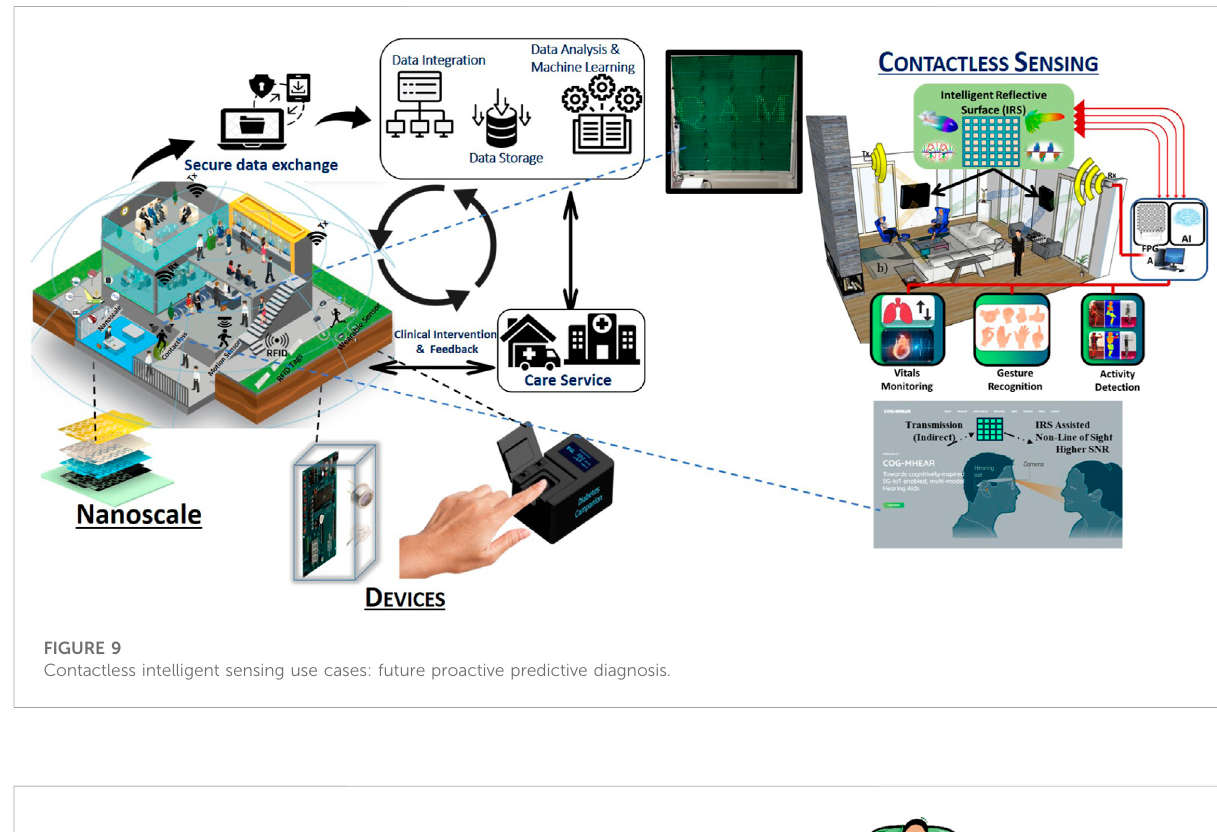
FIGURE 9 Contactless intelligent sensing use cases: future proactive predictive diagnosis.